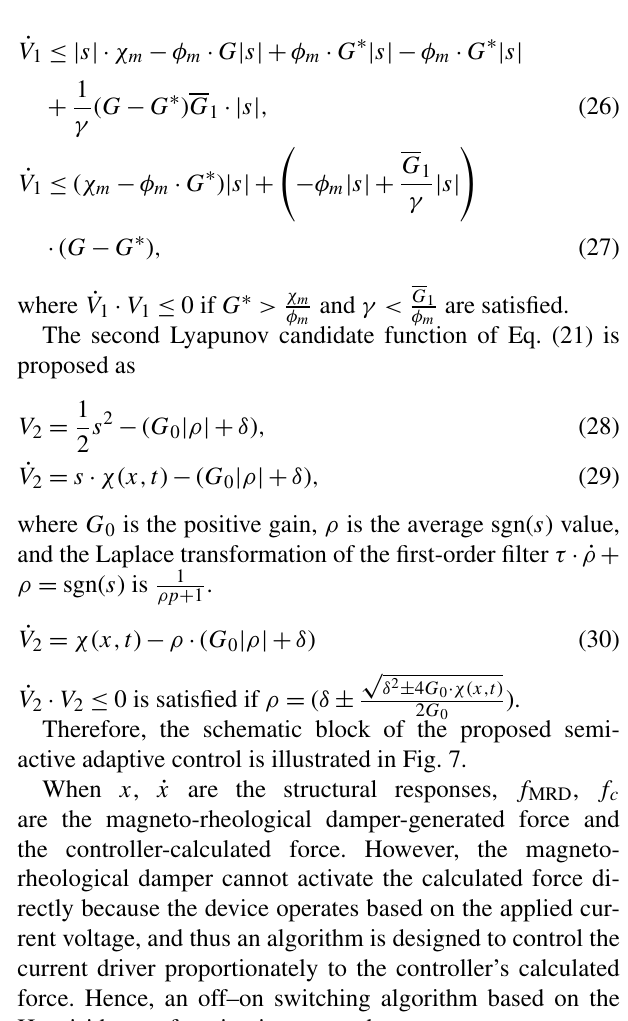
Figure 7. The schematic block of the semi-active adaptive